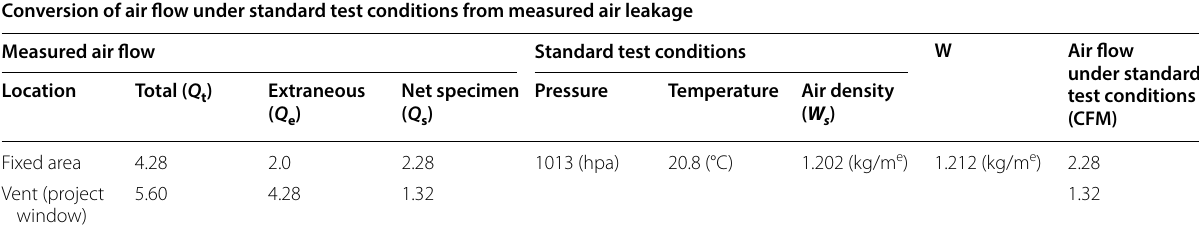
Atmospheric conditions at the location of air flow meter during the test: Atmospheric temperature ( T ): 21.2 °C, Atmospheric pressure ( B ): 1023.0 hpa, Relative humidity: 25.2% Q st Q ( W/W s ) 1/2 , W 3.485 10 − 3 ( B /( T 273)). = = × + Q airflow at non-standard conditions , Q s Q t Q e . = = − Q st airflow corrected to standard =